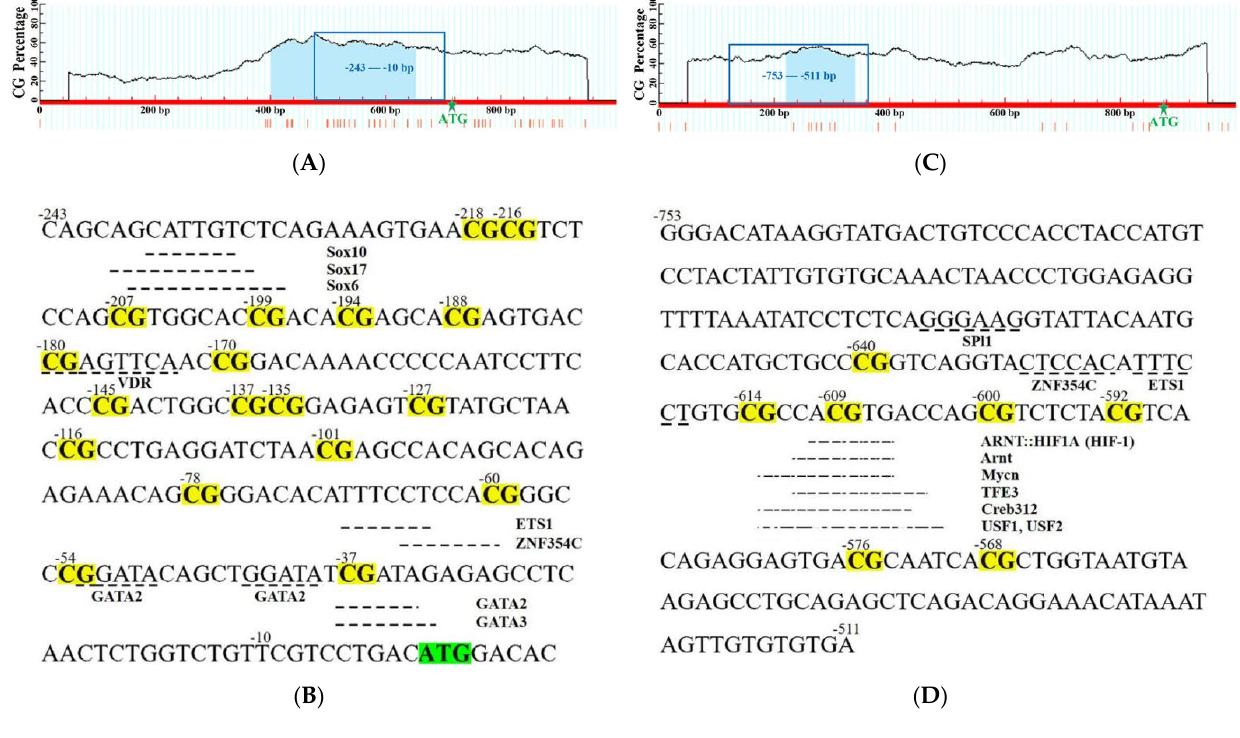
Figure 10. The methylation status measuring sequence analyses of HIF-1 α and LDH-A genes. ( A ) The methylation status measuring region of the HIF-1 α gene. The abscissa indicates a part of the HIF-1 α gene; ordinate denotes CG percentage; light blue shaded part shows the CpG island (CG percentage more than 50%, − 336~+219, 555 bp); blue box represents the methylation status measuring region (234 bp (from − 243 to − 10), with 18 CpG dinucleotides); and green five-pointed star represents the position of start codon (ATG). ( B ) The 234 bp sequence of methylation status measurement in the HIF-1 α gene. The 18 CpG dinucleotides are indicated in yellow shading and the bold letters, and the start codon is shadowed in green and bold. The transcription factor binding sites (TFBSs) are marked with dashed underlines, and their corresponding transcription factors (SOX10, Sox17, Sox6, VDR, ETS1, ZNF354C, GATA2, and GATA3) are near the corresponding TFBSs. ( C ) The methylation status measuring region of the LDH-A gene. Its illustration is the same as Figure 10A except that the abscissa indicates a part of the LDH-A gene; the light blue shaded part shows the sequence with a CG percentage more than 40% ( − 653~ − 535, 119 bp); and the blue box represents the methylation status measuring region (243 bp (from − 753 to − 511), with 7 CpG dinucleotides). ( D ) The 243 bp sequence of methylation status measurement in the LDH-A gene. Its 7 CpG dinucleotides are indicated in yellow shading. TFBSs are shown with dashed underlines, and their corresponding transcription factors (SPl1, ZNF354C, ETS1, ARNT::HIF1A (HIF-1), Arnt, Mycn, TFE3, Creb312, USF1, and USF2) are near